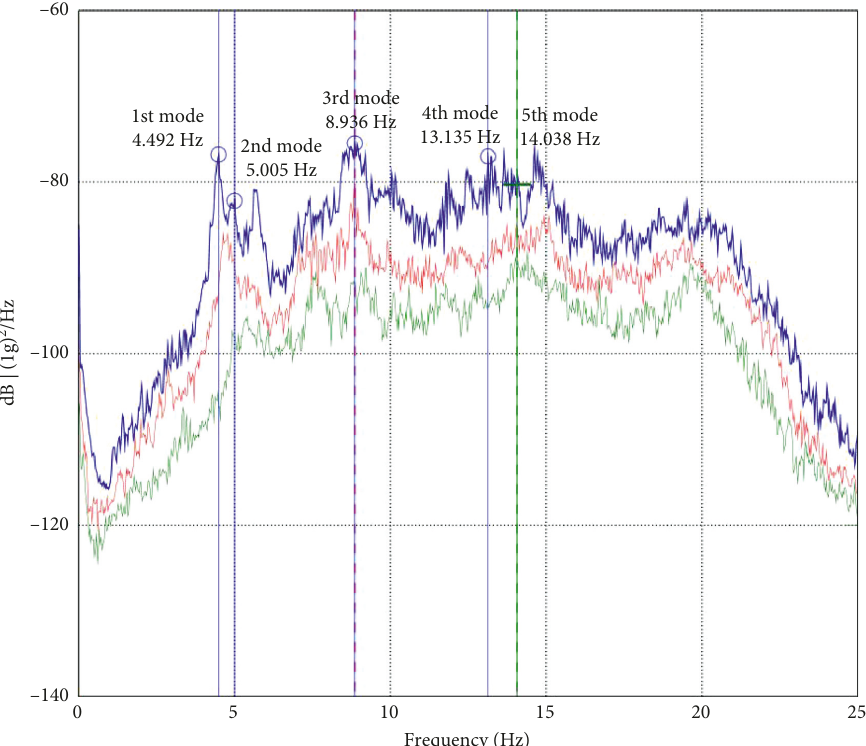
Figure 10: The singular values of the spectral densities of a selected house (House 3 in G¨or¨ukle village).